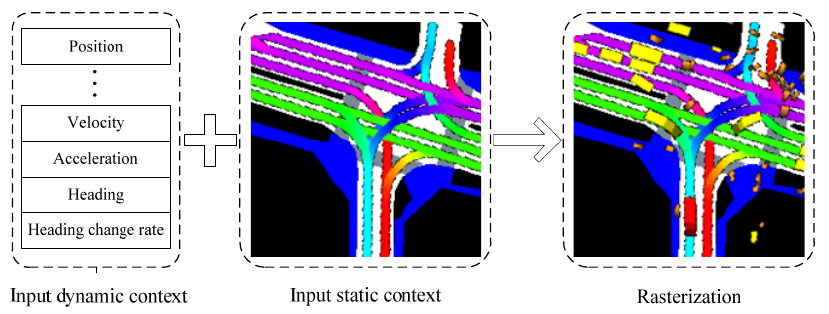
Figure 1. Rasterization for the traffic scene.